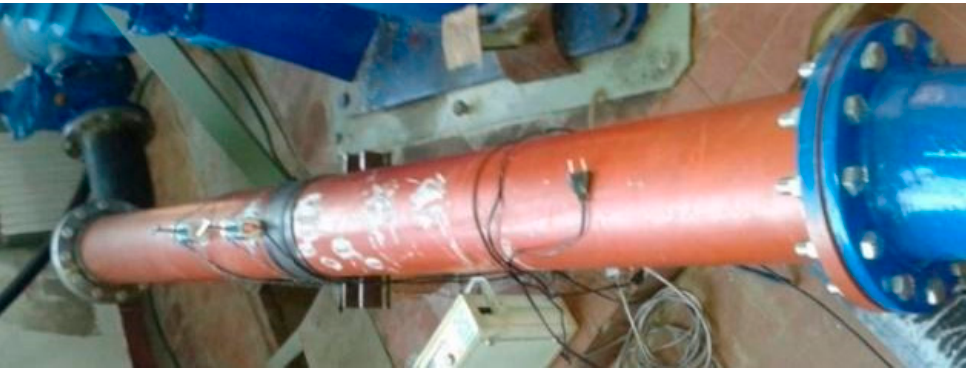
Figure 10. Measuring probes of the portable ultrasonic flowmeter